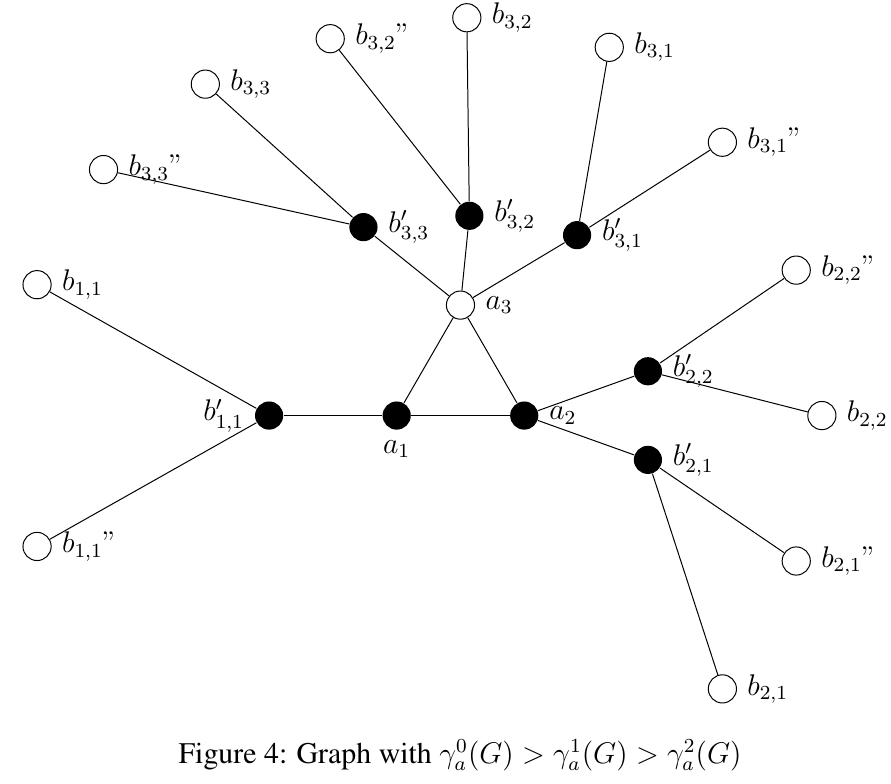
Figure 4: Graph with γ 0